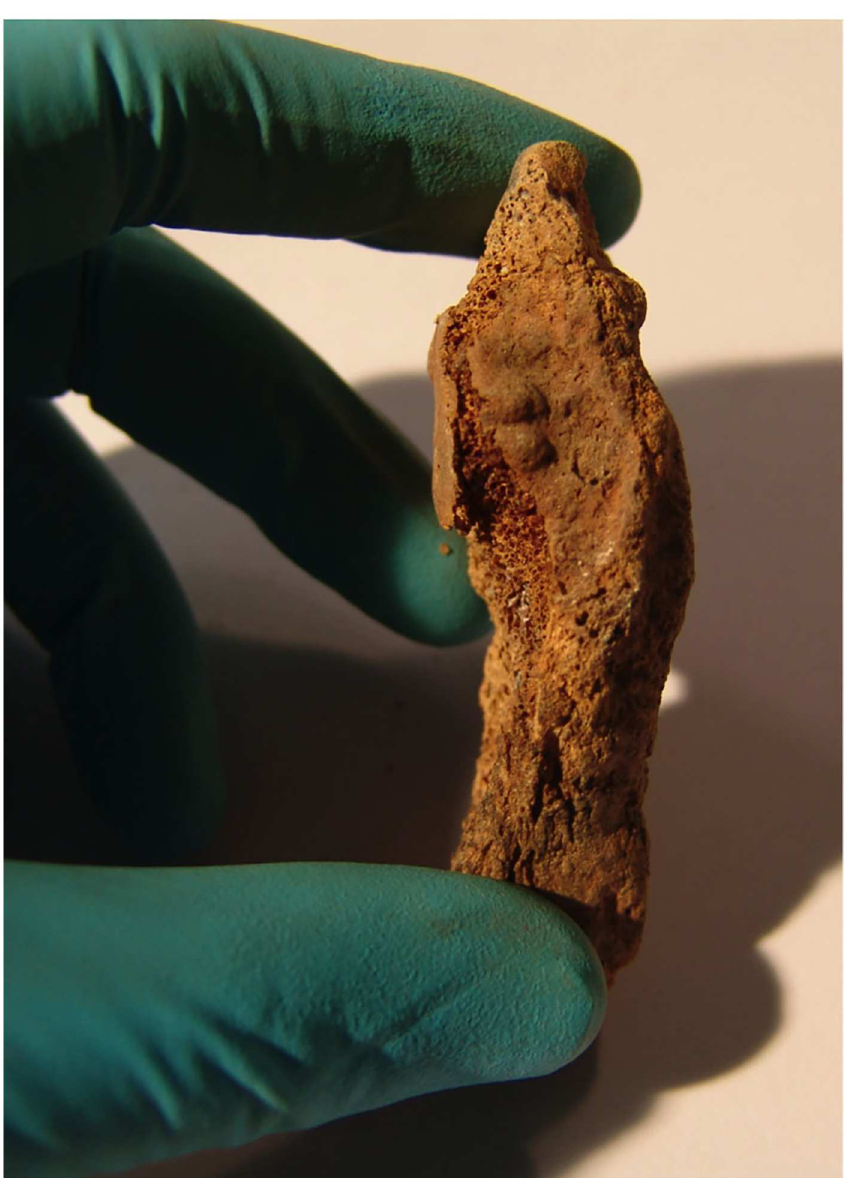
Fig 5. Symphyseal face of the left pubic bone fragment. Note the well-marked ridges and the ventral and dorsal marginsshowingrim formation, consistent with stage II accordingto Acsa´di and Nemeske´ry